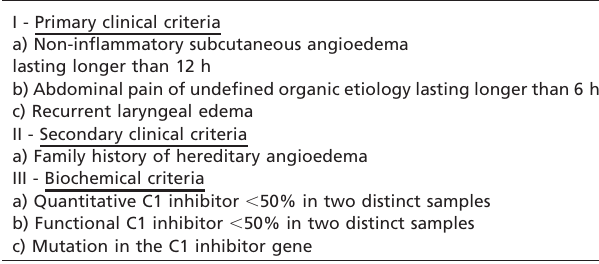
Table 3 - Diagnostic criteria for hereditary angioedema. 36 I - Primary clinical criteria a) Non-inflammatory subcutaneous angioedema lasting longer than 12 h b) Abdominal pain of undefined organic etiology lasting longer than 6 h